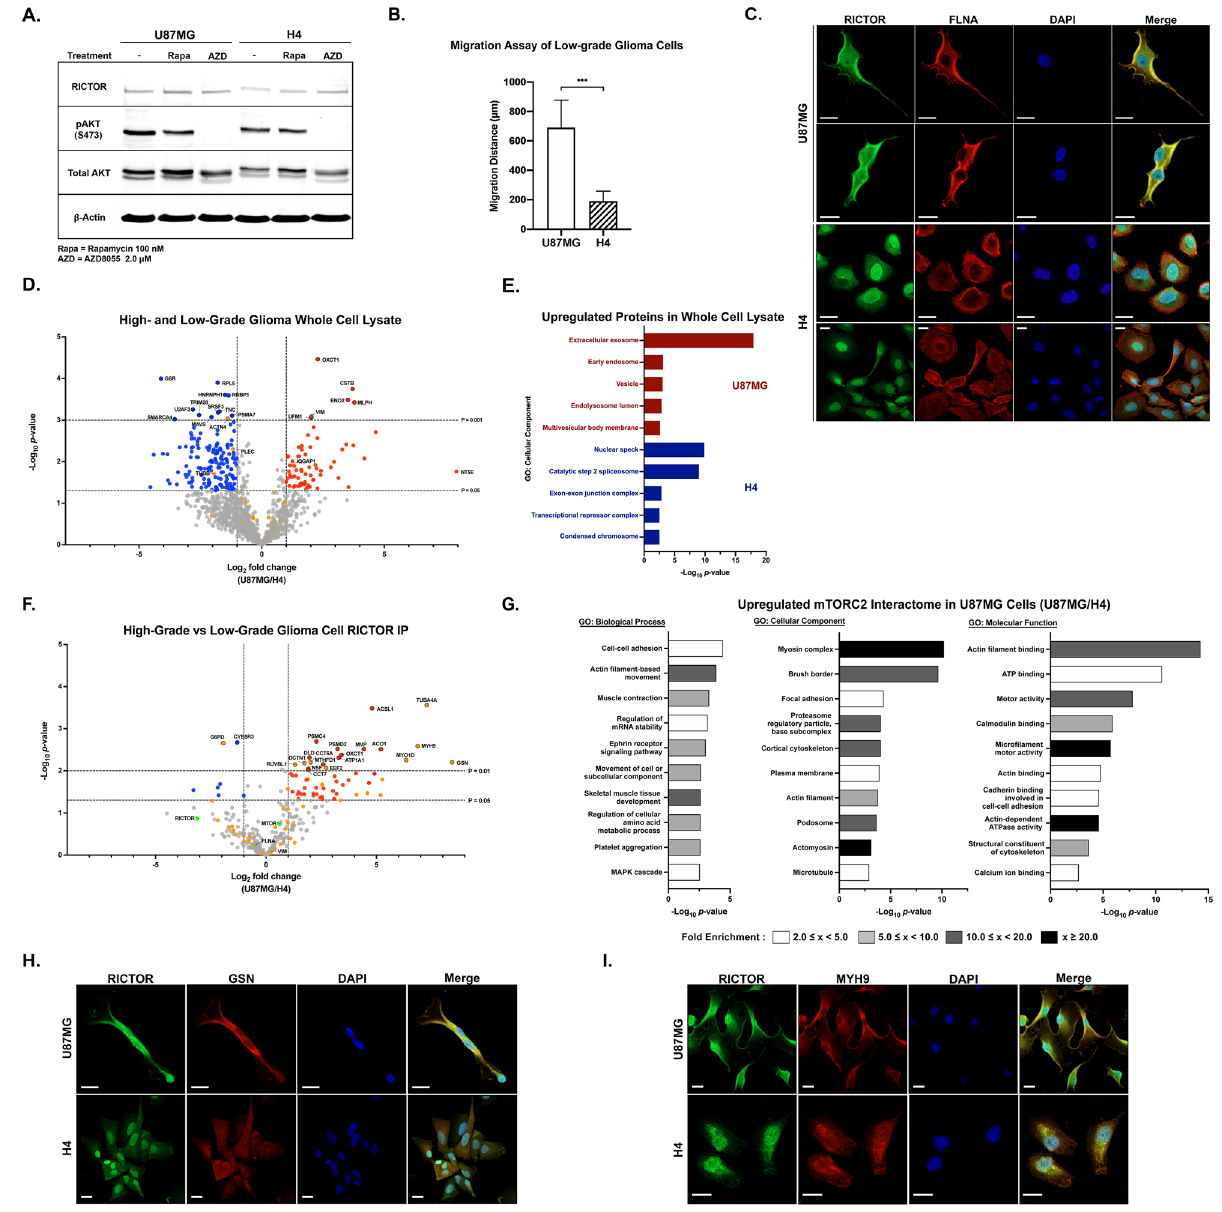
Figure 5. Comparative analysis of the mTORC2 interactome in high- vs. low-grade glioma cells. (A) Western blot of RICTOR levels and mTORC2 activities (pAKT) using U87MG and H4 cell lysates. (B) Comparison of migration distance between U87MG cells (experiment shown in Fig. 1F) and H4 cells under normal conditions; n = 3. All data are the mean ± SD. *** p < 0.001. (C) Immunofluorescence analysis showing different localizations of RICTOR and FLNA in U87MG and H4 cells. Scale bar = 20 µm. (D) Volcano plots of proteomic analysis from U87MG and H4 whole-cell lysates; n = 3 biological replicates. Proteins with log 2 fold change (LFQ U87MG/H4) ≥ 1, p < 0.05 are highlighted in red, while proteins with log 2 fold change ≤ -1, p < 0.05 are highlighted in blue. Proteins with p -values < 0.01 are shown with a black border. Statistical significance was calculated from the LFQ values of each common protein of the two conditions using an unpaired two-sided Student’s t-test. All cytoskeletal proteins are shown in orange. (E) Gene ontology analysis showing GOCC terms of upregulated and unique proteins of the cell line comparing U87MG and H4 cells. Plots showing ten top-ranked -log 10 ( p -value) GOCC terms with FDR < 0.05 of each cell line. (F) Volcano plots of the results of the AP-MS experiments in (J) showing changes in mTORC2-associated proteins in U87MG cells compared to H4 cells; n = 3 biological replicates. Proteins with log 2 fold change (LFQ U87MG/H4) ≥ 1, p < 0.05 are highlighted in red, while proteins with log 2 fold change ≤ -1, p < 0.05 are highlighted in blue. Proteins with p -values < 0.01 are shown with a black border. Statistical significance was calculated from the LFQ values of each common protein of the two conditions using an unpaired two-sided Student’s t-test. Key mTORC2-interacting proteins are shown in green circles. All cytoskeletal proteins are shown in orange. (G) Gene ontology analysis of increased/presented proteins in the mTORC2 interactome of U87MG cells. Plots showing top -log 10 ( p -value) GOBP, GOCC, and GOMF terms with FDR < 0.05 and the bar colors representing fold enrichment of each specific term. (H,I) Immunofluorescence analysis of RICTOR and GSN (M) or MYH (N) in U87MG and H4 cells. Scale bar = 20